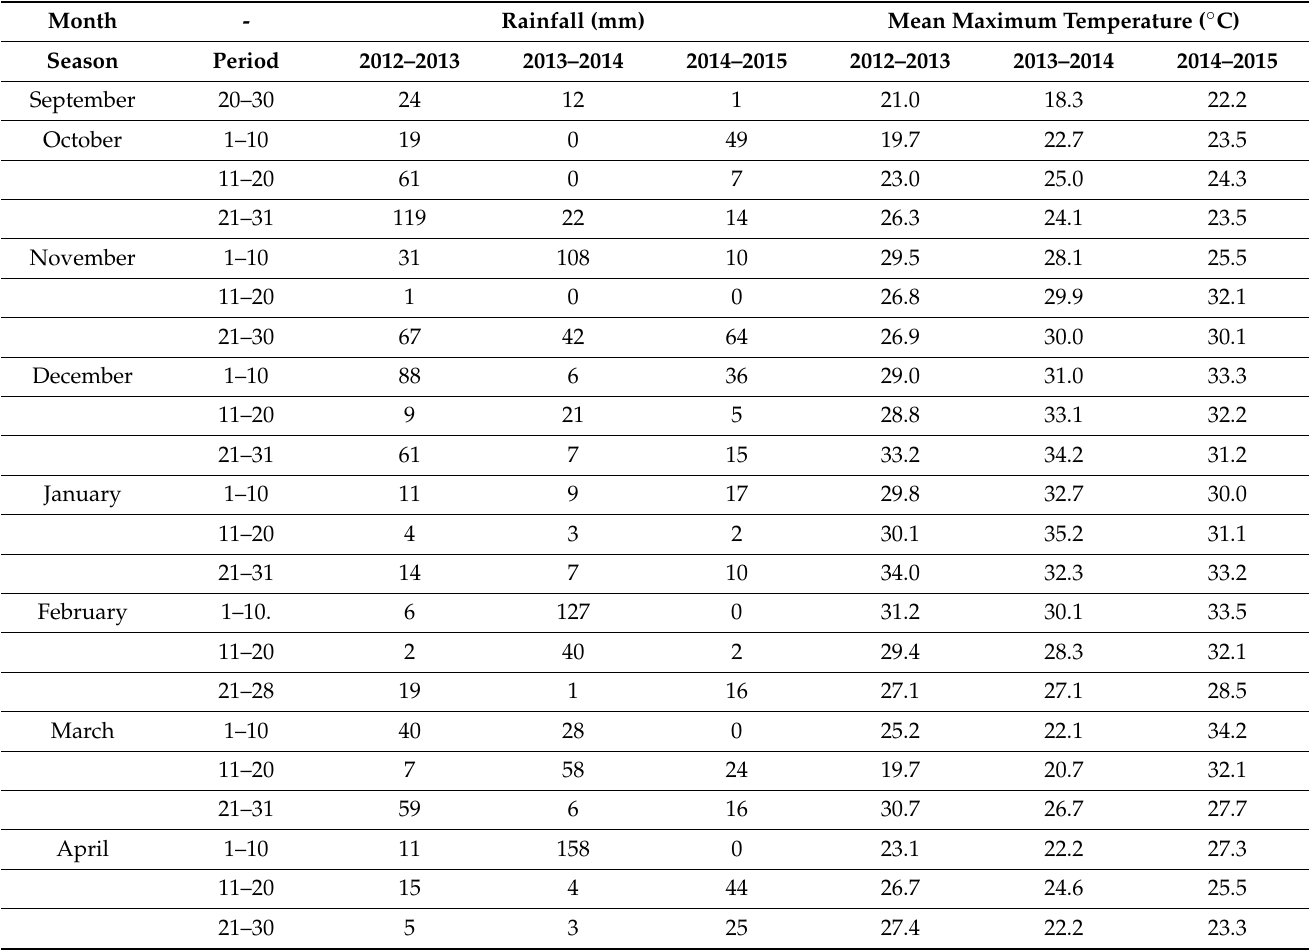
Table 1. Ten-day aggregation of rainfall and temperature data recorded for Trenque Lauquen (Provincia de Buenos Aires, Argentina) for the sunflower growing seasons of 2012–2013, 2013–2014, and 2014–2015 (after INTA